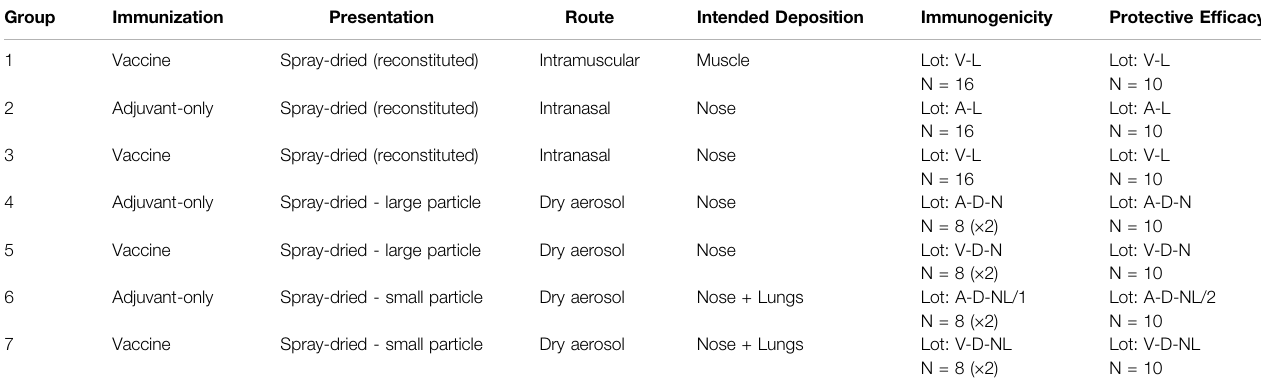
TABLE 1 | Experimental matrix for the assessment of administration route of spray-dried ID93+GLA-SE forms in mice. Nomenclature: V – Vaccine; A – Adjuvant; L – Liquid; D – Dry powder; N – Nose; NL – Nose and Lung.